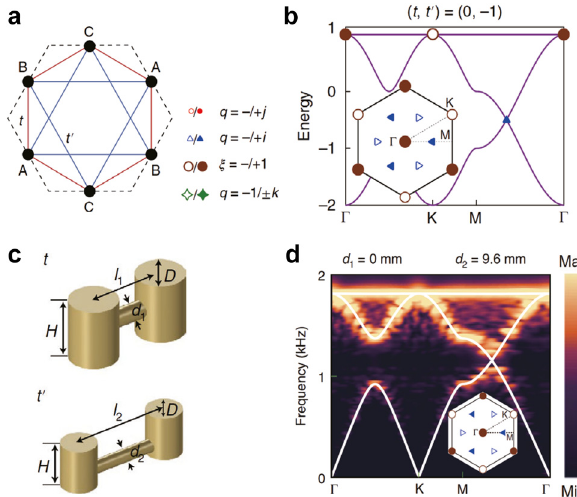
Figure 9: Experimental realization of Euler class using a phononic crystal. (a) Schematics of a Kagome tight-binding model with tunning parameters t and t ′ . (b) Phononic band structure of (a). (c) Experimental design of (a). (d) Simulation (white plots) and experimental band structure of (c). Reproduced with permission from Reference [124]. Copyright 2021, Nature Portfolio